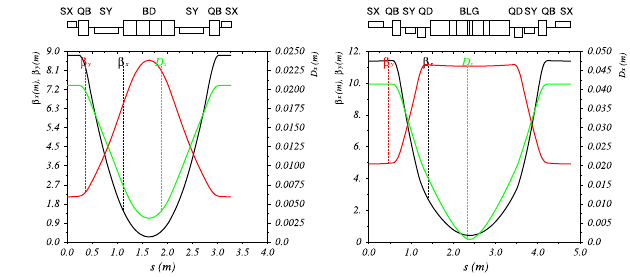
FIG. 26. Optical functions of scaled mTME SKIF cell on the left ( E ¼ 6 GeV, ε x ¼ 30 pm, L c ¼ 3 . 27 m) and cell with longitudinal field gradient dipole on the right ( E ¼ 6 GeV, ε 30 pm, L 4 . 78 m). x ¼ c ¼